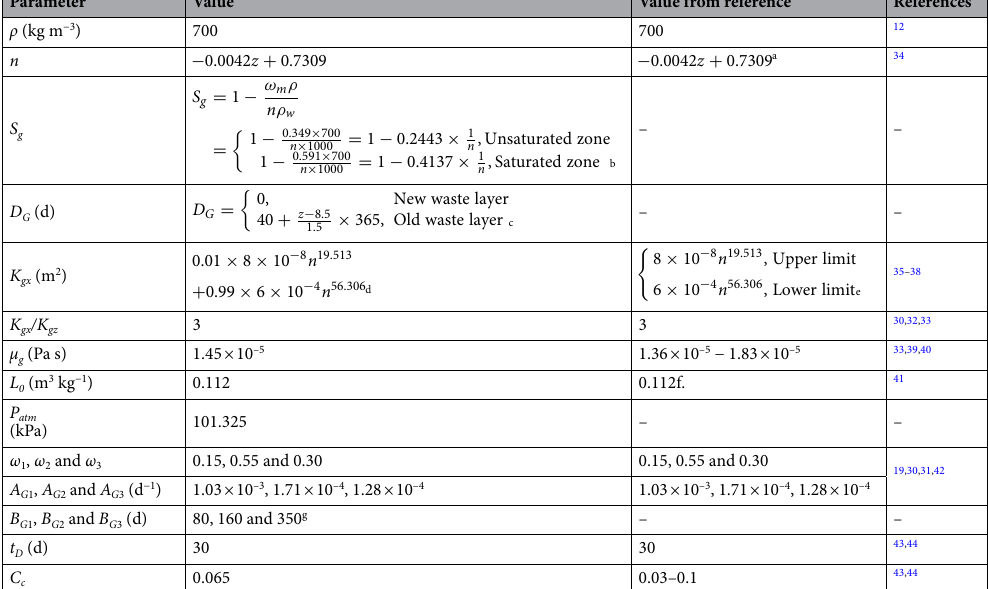
where τ is the step length of time; ot ( t ) and oz ( z ) are the node functions in time and the vertical direction, respectively. The gas pressure distribution in the monitoring test conducted by Zhang et al. 12 is studied, and the layout of the field test site can be viewed in the paper of Zhang et al. 12 . In order to select reasonable calculation parameters, the parameters which are suitable for the Wuxi landfill are selected. The parameters used in the numerical cal- culation are shown in Table 1. In the process of numerical calculation, the step length in the vertical direction is 0.5 m and the step length of time is one day. The equation of gas transport in this study is a parabolic equation, and its difference scheme (Eq. 8) is a classical implicit scheme. Therefore, the iterative method is used to solve the difference equation with absolute convergence using any mesh ratio. The stratification of the unsaturated and saturated waste is realized by distinguishing the gas saturation above and below the leachate level. The stratifica- tion of the new and old waste is realized by distinguishing the length of time that waste has been degraded to produce gas in the new and old waste layers. In addition, in order to simulate the actual landfill, the variations of gas permeability and porosity with depth, the anisotropic ratio of gas permeability, and the settlement caused by waste biodegradation were also considered. The variation of gas pressure with time in the newly filled MSW layer of the Wuxi landfill was obtained by numerical calculation, as is shown in Fig. 5. Both the theoretical calculation value and the monitoring value of gas pressure show the single peak trend, which is similar to the trend of waste biodegradation rate 27 . It is worth noting that the gas pressure in #0 well (extraction well) is the mixed gas pressure within the entire perforated pipe (length: 7.7 m). In order to calculate the gas pressure in the gas collection well, the gas pressure in the waste body is integrated into the direction of the length of the perforated pipe. Then the result obtained by integration is divided by the length of the perforated pipe, and the average gas pressure in the gas collection well is obtained, as is shown in Fig. 5a. When the leachate level is always higher than the bottom of the monitoring well (e.g. #6 well), or when the bottom of the monitoring well (e.g. #3well and #5 well) is submerged due to the increase of leachate level in the later period, the gas pressure below the leachate level is not monitored in the field test of Zhang et al. 12 . However, the gas pressure below the leachate level in the landfill can be theoretically calculated, as is shown in Fig. 5b–d. The calculation value is compared with the field test value in Fig. 5, it can be also found